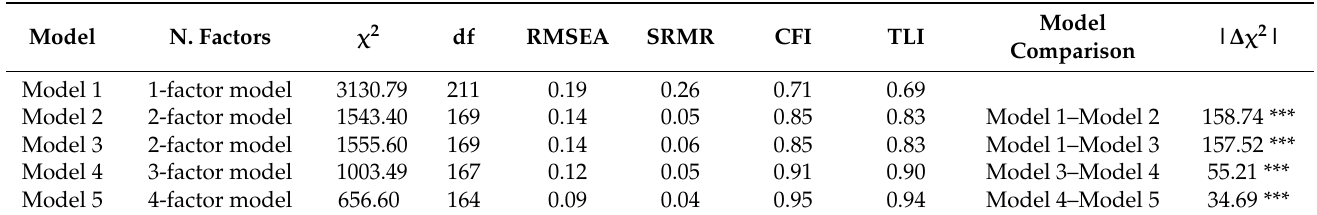
Table 1. Fit Indices of Competing Nested Factor-models, Standardized Maximum Likelihood Estimates ( N = 400). Model N.